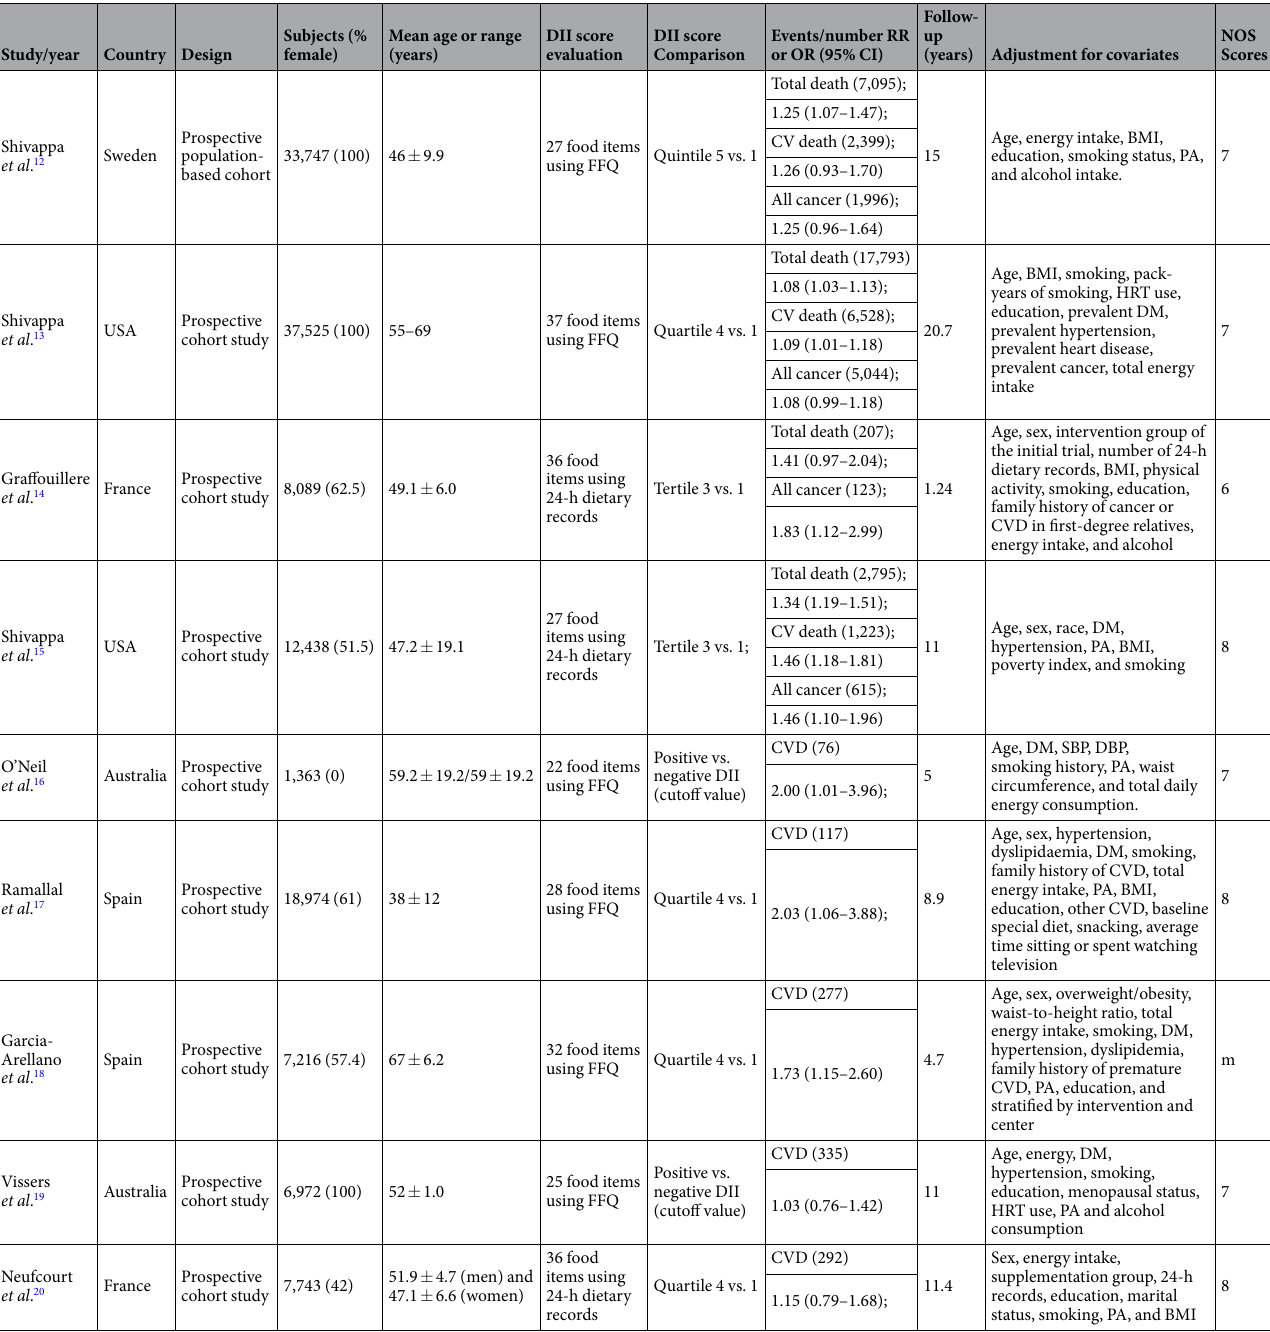
Table 1. Characteristics of studies included in meta-analysis. Abbreviations: OR, odds ratio; HR, hazard ratio; CVD, cardiovascular disease; CV, cardiovascular; DM, diabetes mellitus; SBP, systolic blood pressure;